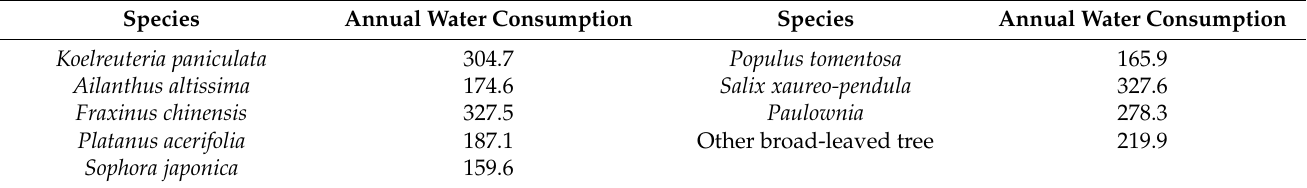
Table 7. Annual water consumption per unit of leaf area of broad-leaved trees